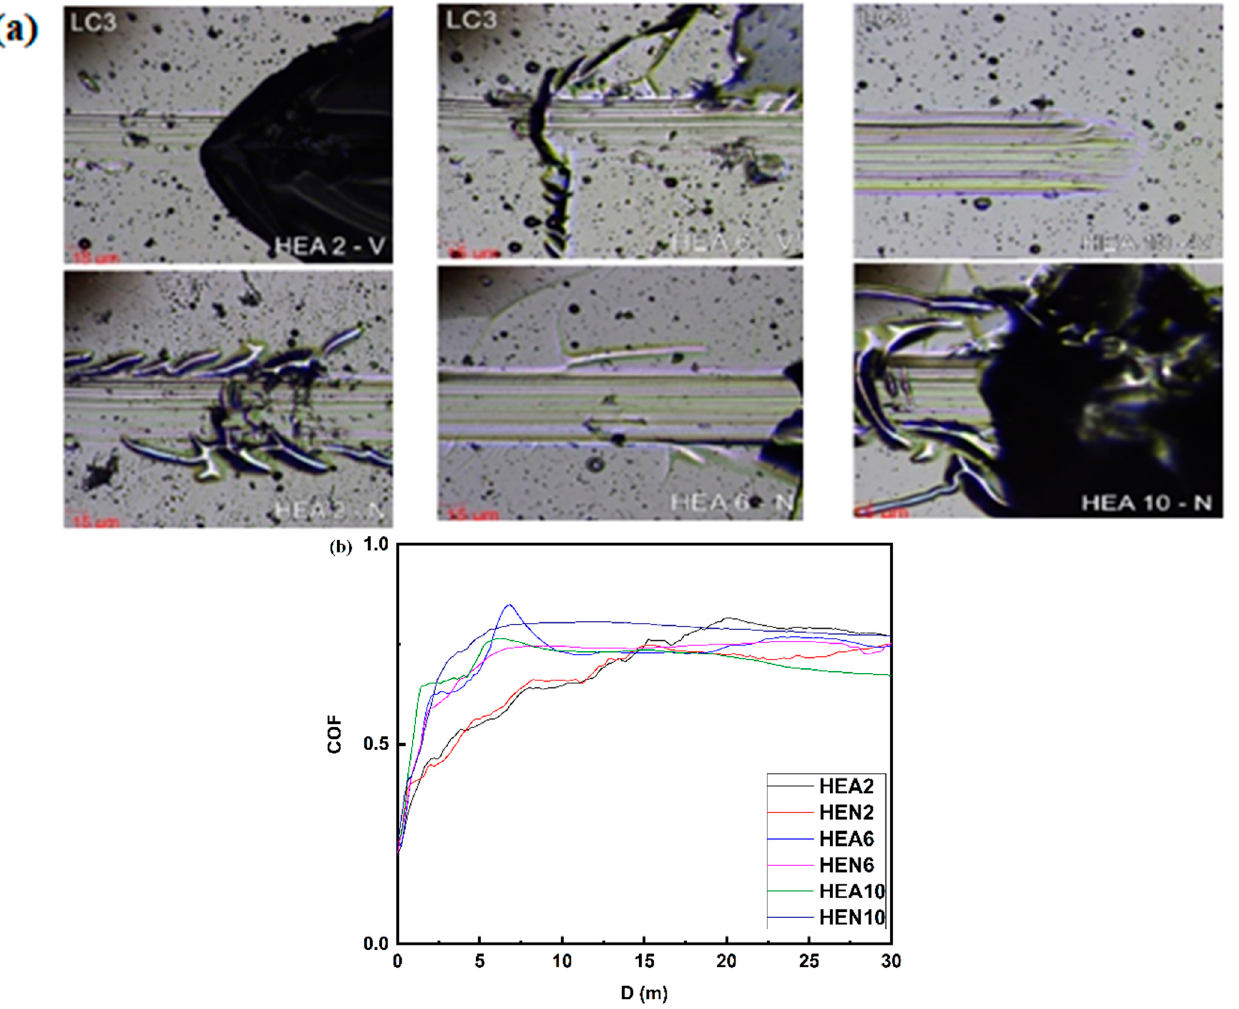
Figure 11. Obtained optical micrographs from scratch tests by critical load LC3 performed on ( a ) the thin HEA and HEN films with nickel concentration 0.4, 1.2, and 2.0 respectively, displayed on vertical from left to right, and ( b ) plotted data on the variation of the dynamic friction coefficient, as function of distance, obtained in dry conditions against Al 2 O 3 balls.